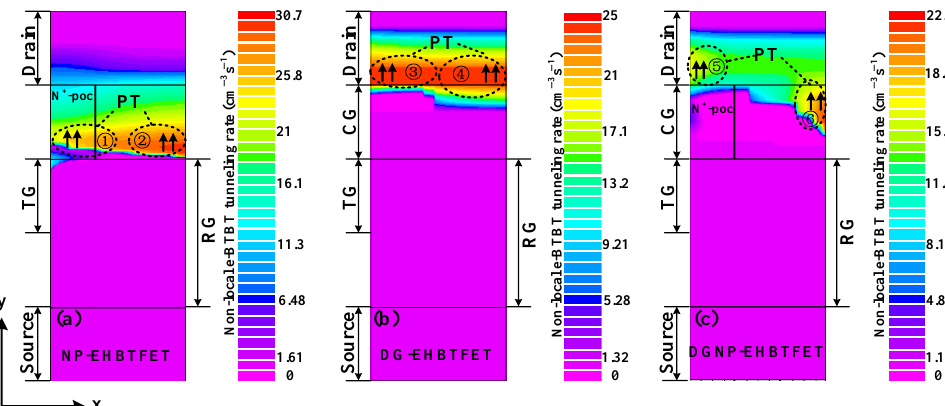
Figure 2. Contour plots of the vertical non-local e-BTBT tunneling rate for ( a ) NP-EHBTFET; ( b ) DG- EHBTFET; and ( c ) DGNP-EHBTFET, in the OFF-state.